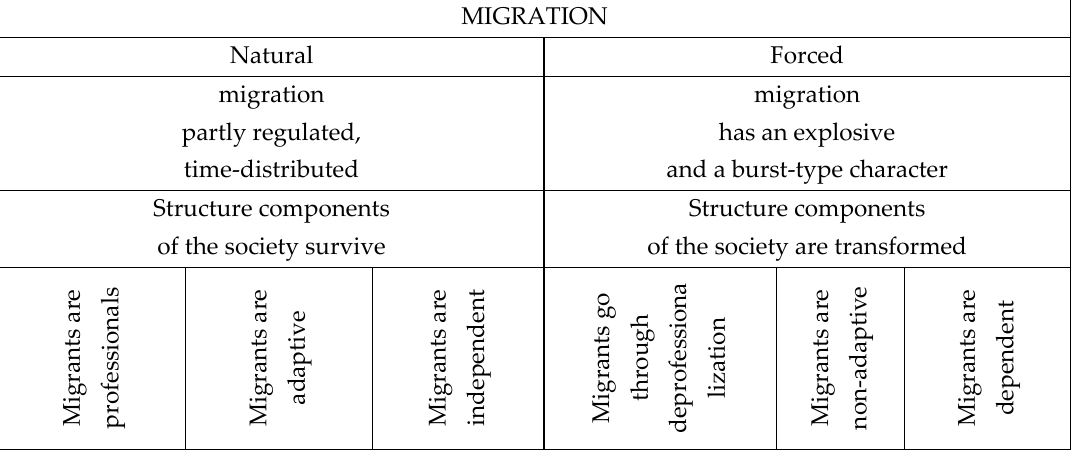
Figure 3. Natural and forced of migration [7].